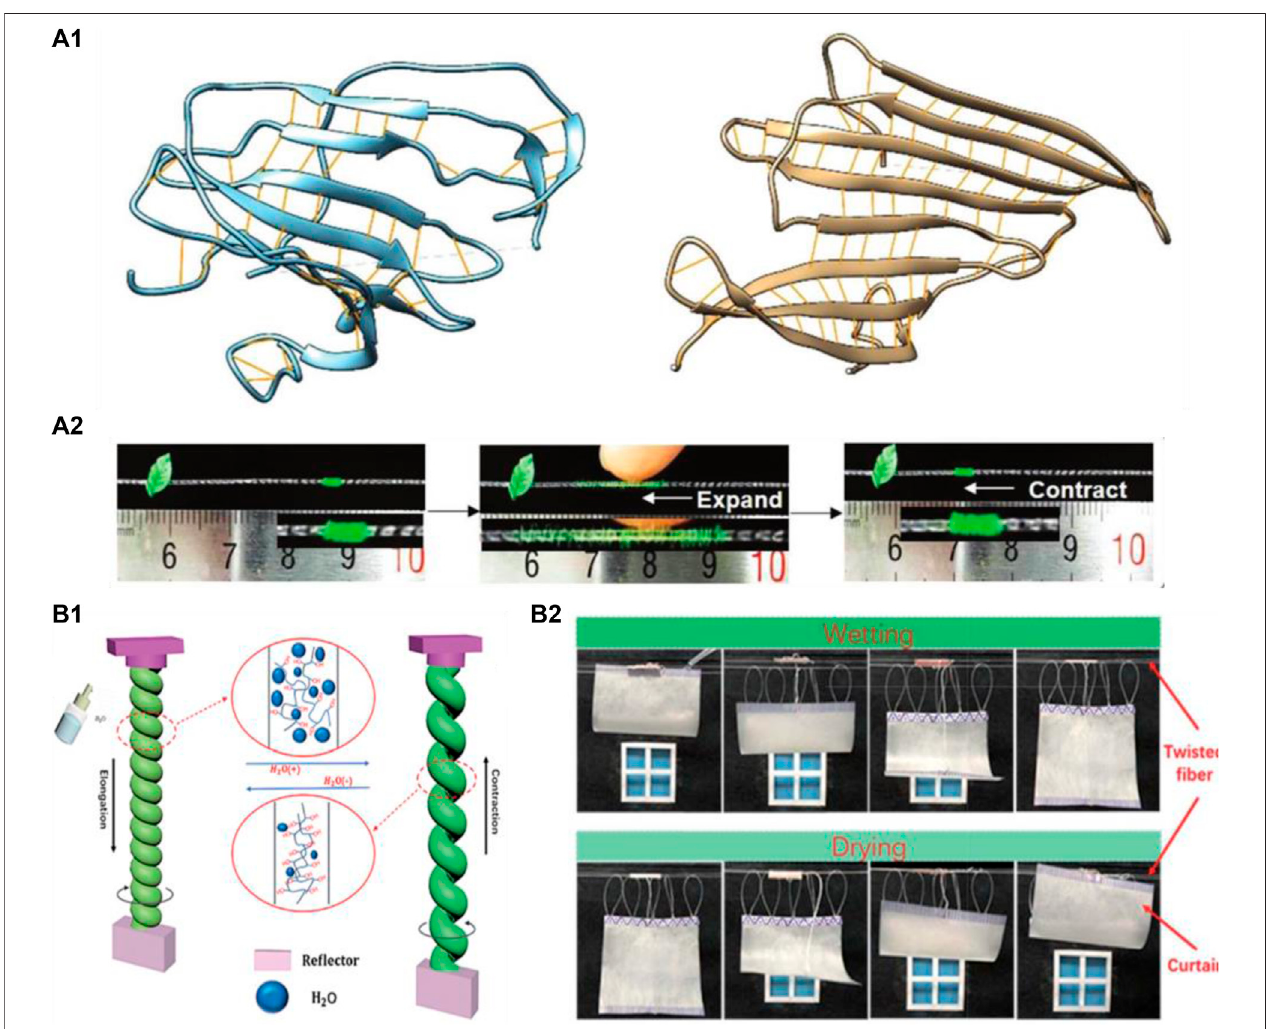
FIGURE 4 | (A1) Molecular dynamic simulation of the proteins before and after water molecules added, the loop structure undergoes transition into a protein secondarystructure,andthestructurebecomesmoreregular. (A2) arobotic “ caterpillar ” walkingonabarbedwirebymoisturestimulation.ReproducedfromJiaT.etal. (2019)withpermissionofWILEY-VCH. (B1) thetwisted fi berrapidswellingoccurredunderwaterstimulation,leadingtofastrotation.Afterthewaterevaporated,the fi ber quickly returned to its original state. (B2) Schematic diagram of the smart rainy curtain. Reproduced from Wang et al. (2018c) with permission of Royal Society of